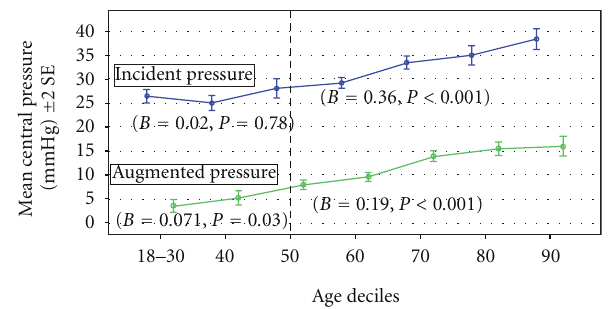
Figure 1: Augmented pressures and incident pressures in younger and older subjects by deciles of age.